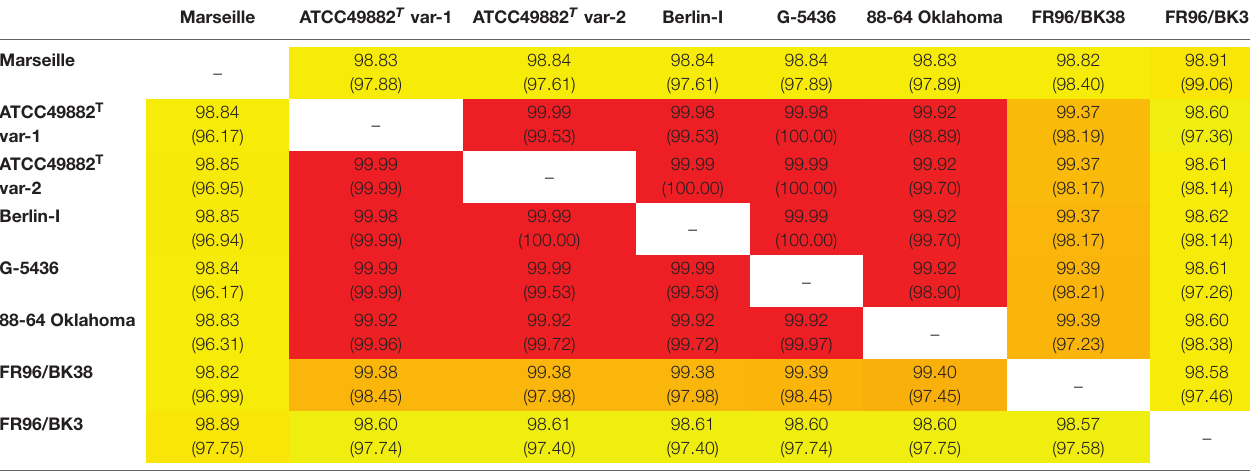
TABLE 2 | Genome comparison as per average nucleotide identity (ANI) based on MUMmer